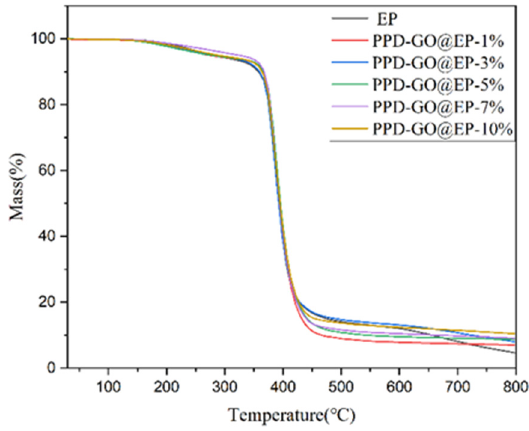
Figure 4. XPS spectra of GO and PPD-rGO. ( a ) Full spectrum; ( b ) C 1s spectrum of GO; ( c ) C 1s spectrum of PPD-rGO.